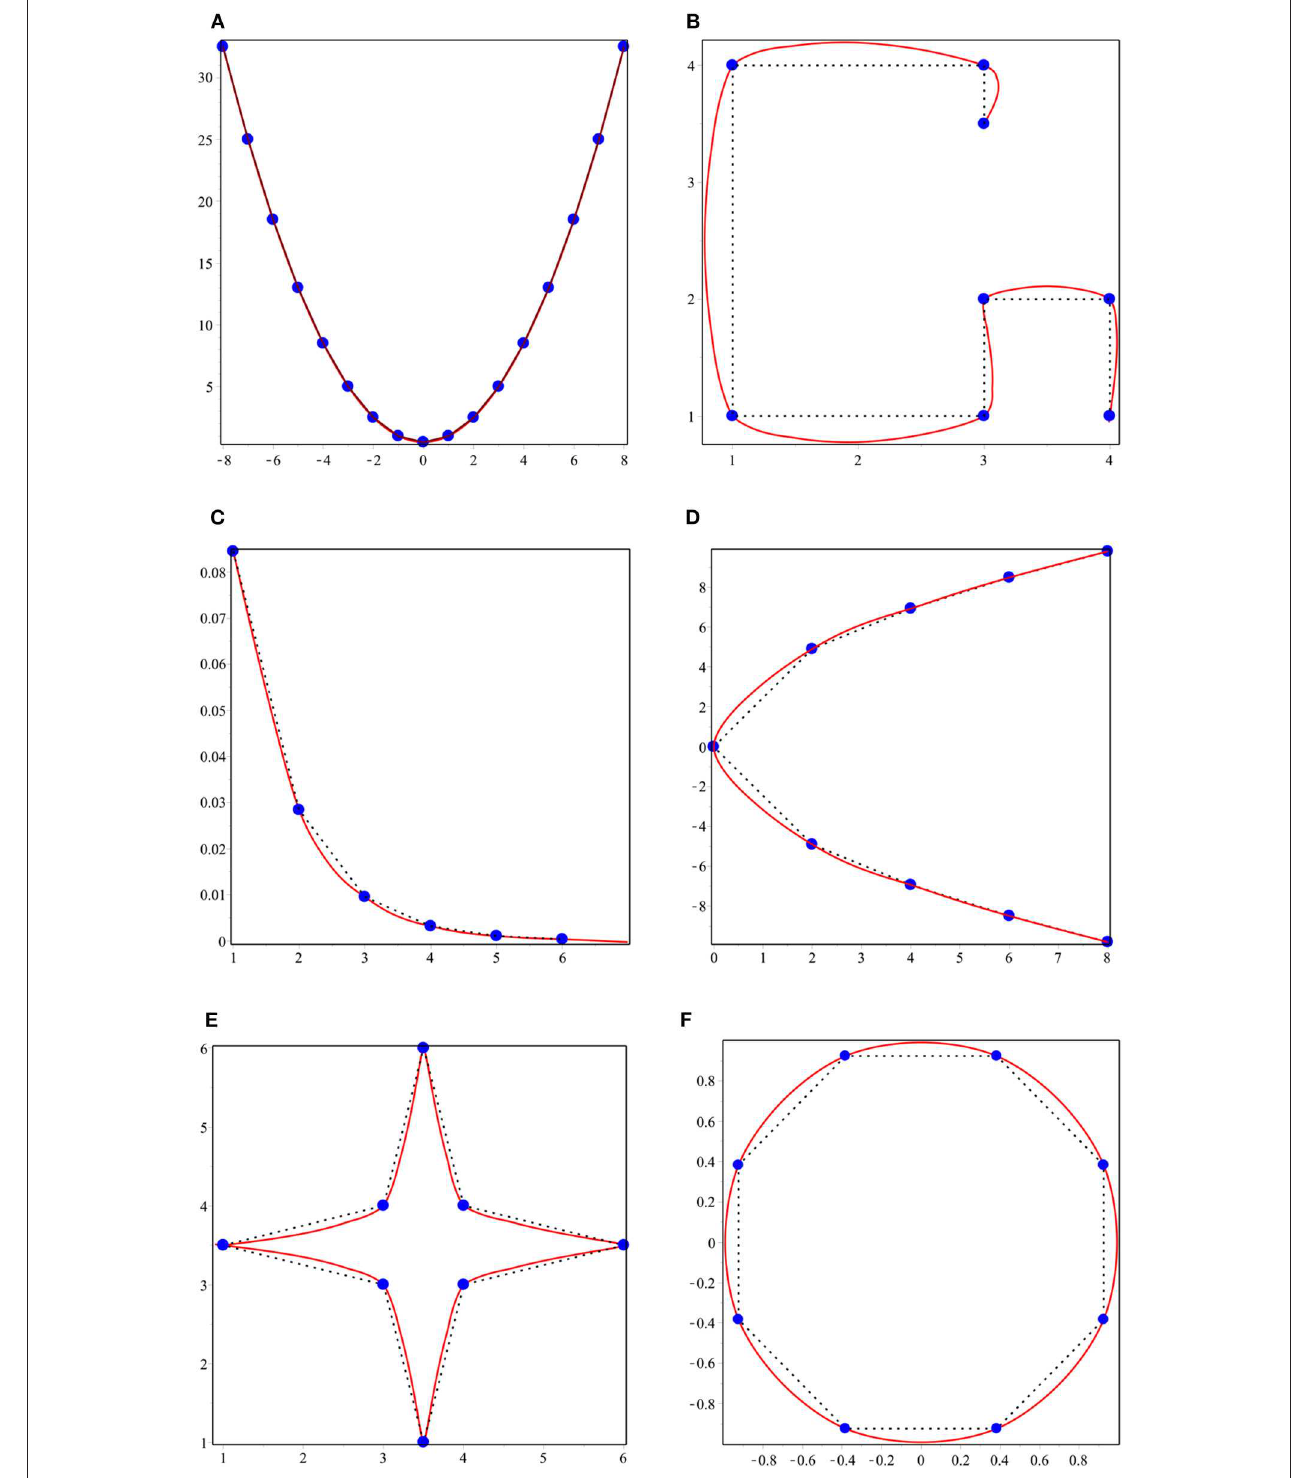
FIGURE 1 | The convexity-preserving limit curves generated by the proposed scheme with the control polygon.